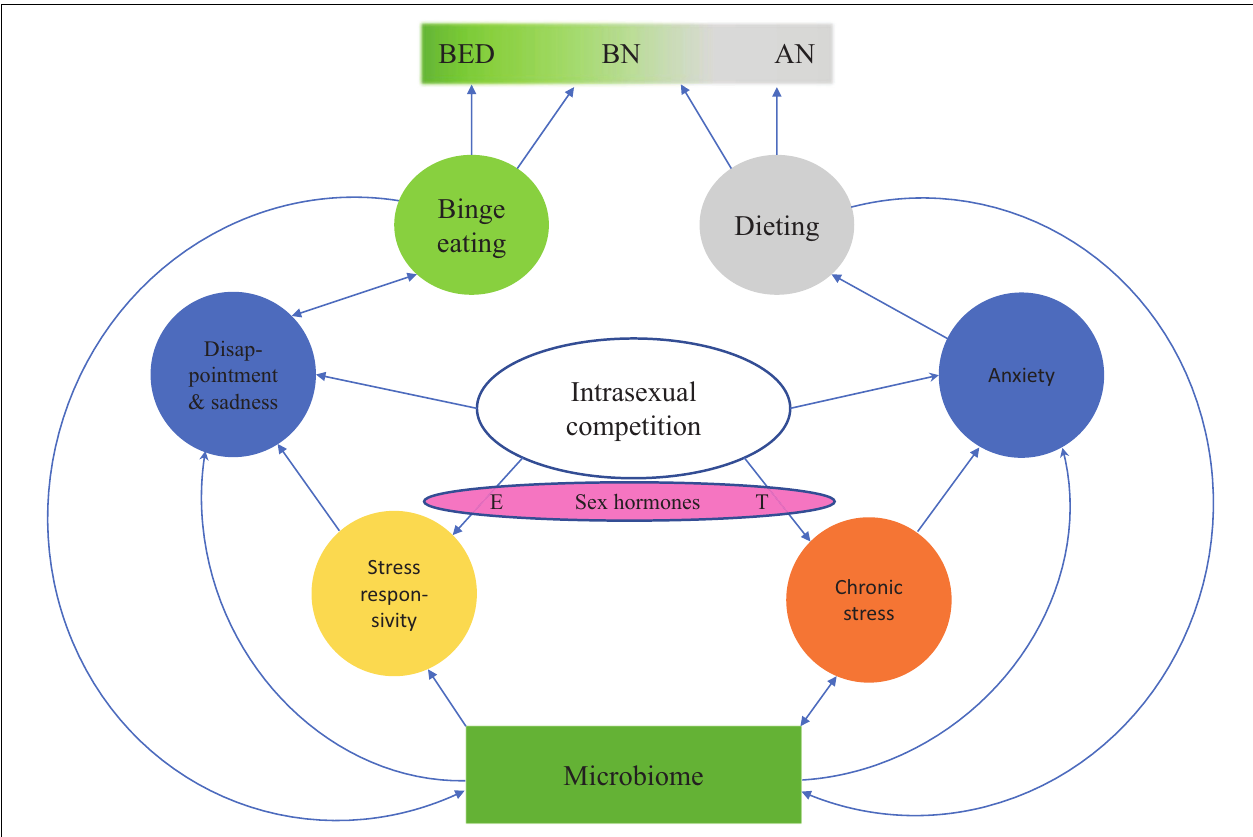
FIGURE 2 | An evolutionary psychoneuroimmunological continuum model for eating disorders. The model shows how intrasexual competition for thinness leads to various emotion states (blue circles). Individual differences in these emotion states and the resulting eating behaviors (green and gray circles) are partially driven by individual differences in prenatal sex hormone exposure as well as premorbid and current microbiome constitution. Thus, between-individual and within-individual variation in eating disorders can arise from dynamic shifts in inflammation, stress, serotonin levels, tryptophan concentrations and the microbiota. BED, binge eating disorder; BN, bulimia nervosa; AN, anorexia nervosa; E, estrogen; T,